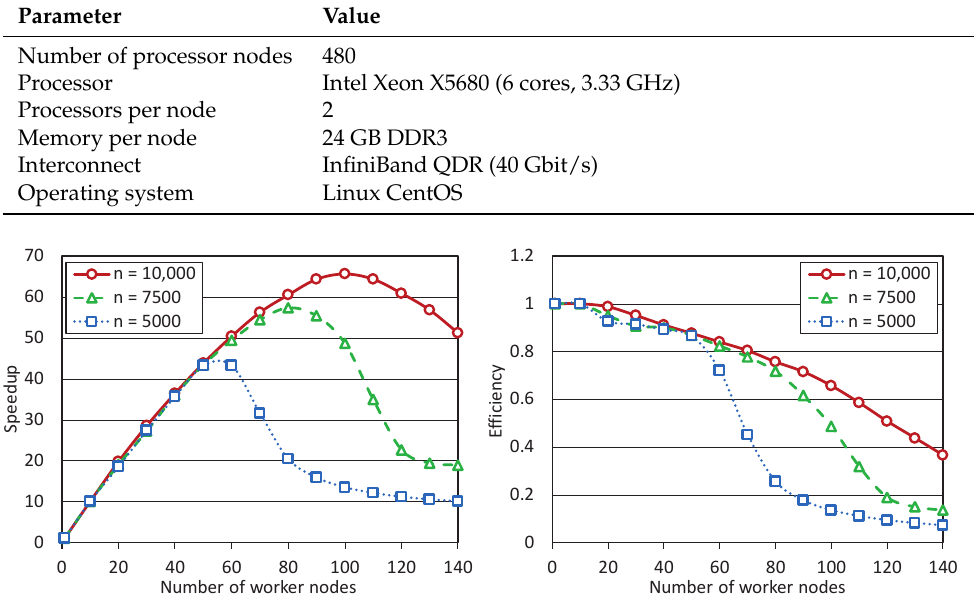
Figure 2. Speedup and efficiency dependency for various dimensions on the number of worker